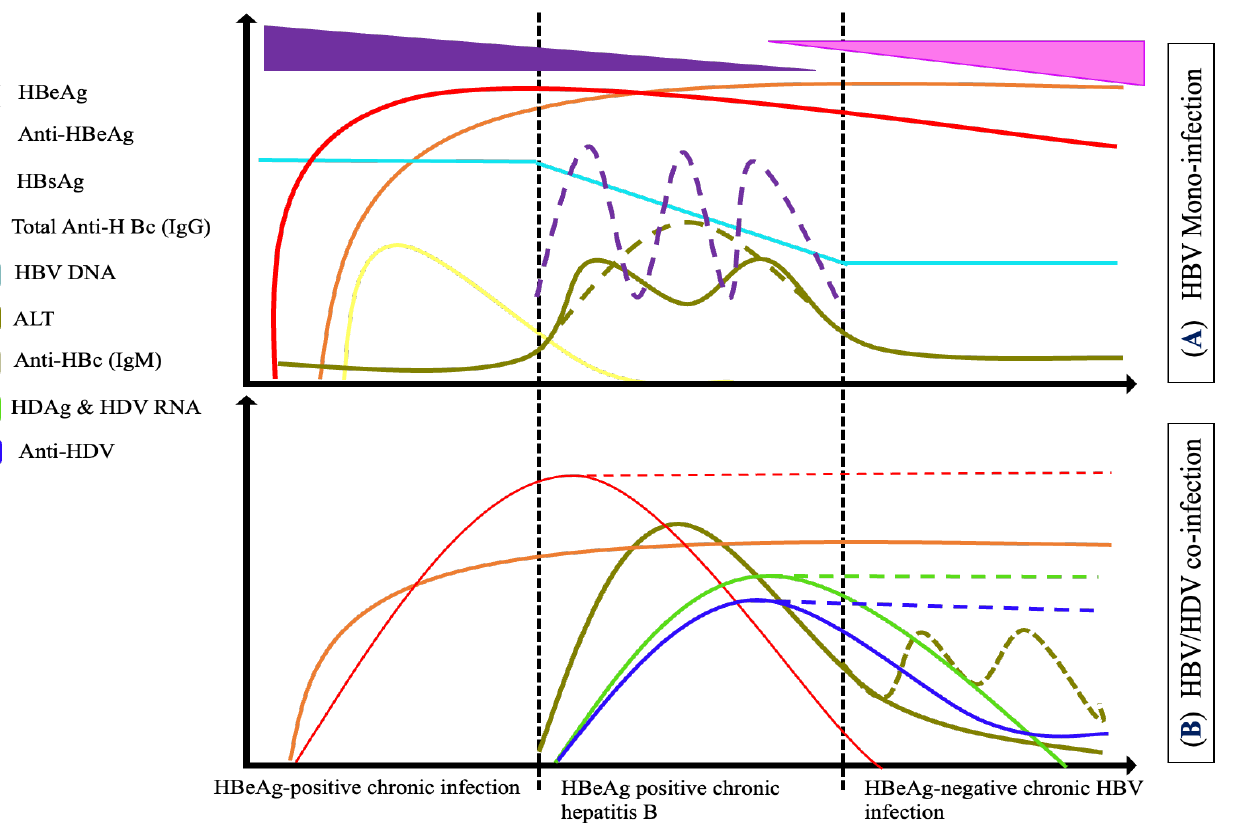
Figure 2. serological markers of HBV monoinfection (A) and HBV/HDV coinfection (B): the di- agnosis of HBV monoinfection and HBV/HDV coinfection is based on simultaneous detection of different serological markers. The markers of chronic HBV and acute HDV include HBsAg, HBeAg, HBV DNA, anti-HDAg, HDV RNA and immunoglobulines M and G. The HDV markers are present only transiently and disappear during early remission. Antibodies to HDV also disappear with time in acute resolving HDV infection.